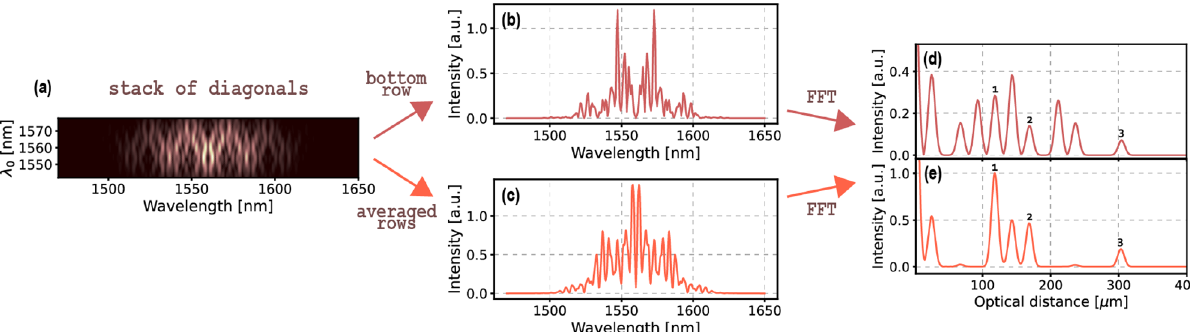
Figure 2. Using the example from Fig. 1, ( a ) a stack of diagonals consists of 50 most central diagonals of the joint spectrum and covers the central wavelength range of 35 nm. ( b ) The central row spectrum of the stack— when Fourier transformed (FFT)—gives ( d ) an A-scan which is cluttered with artefacts. ( c ) Complex averaging of the spectra in the stack of diagonals outputs a spectrum which—when Fourier transformed—gives ( e ) an A-scan where the artefacts are reduced or completely suppressed. 1, 2 and 3 number the peaks representing the structure of the